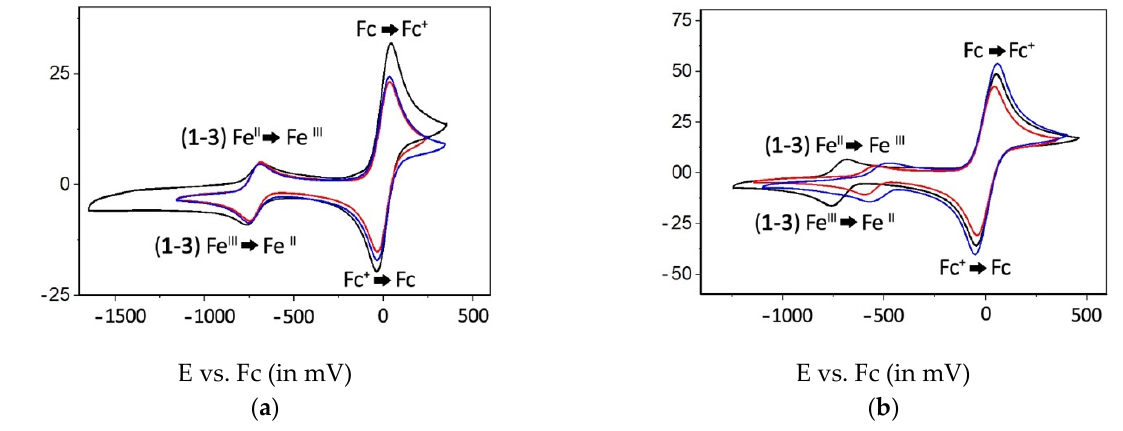
Figure 9. Voltammograms of compounds 1 (black), 2 (blue), and 3 (red) (1 mM) in DMSO ( a ) and DCM ( b ) vs. Fc (2 mM).